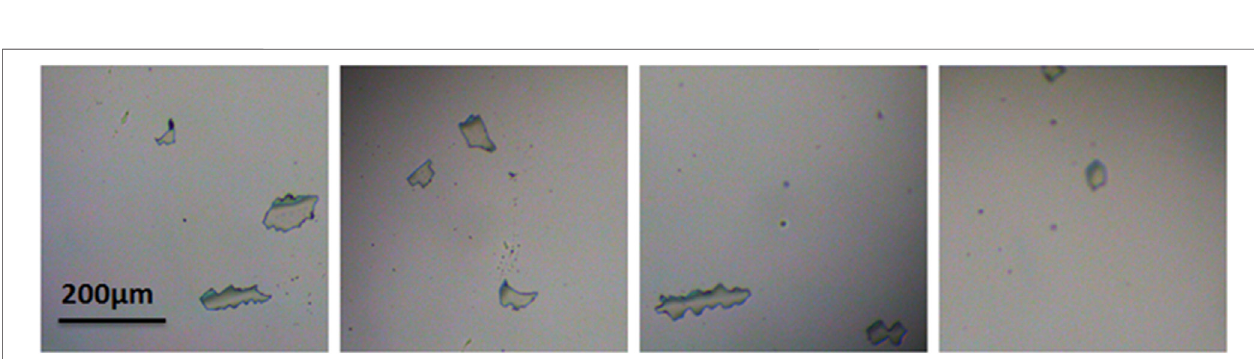
FIGURE 4 | The residues on the surface of as-implanted 128 ° Y – X LN with a He ions dose of 6.0 × 10 16 ions cm − 2 .